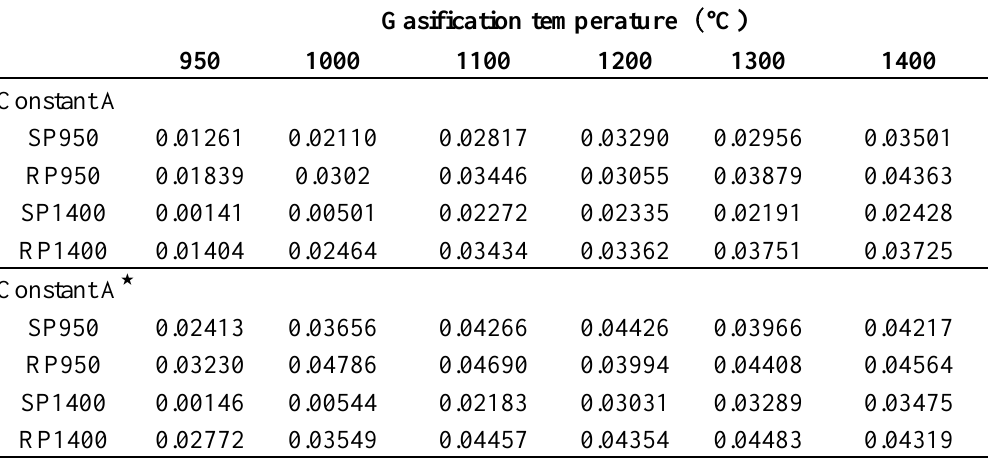
Table 3. The values of A and A ★ calculated by the fit of experimental data respectively using the MVM and the